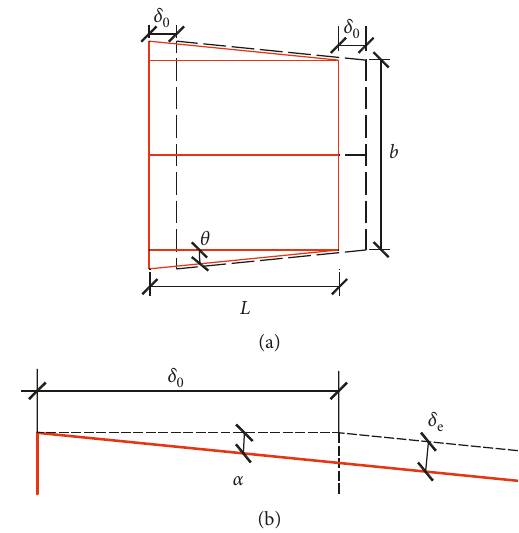
Figure 7: Side view of the tenonunder (a)slippage and